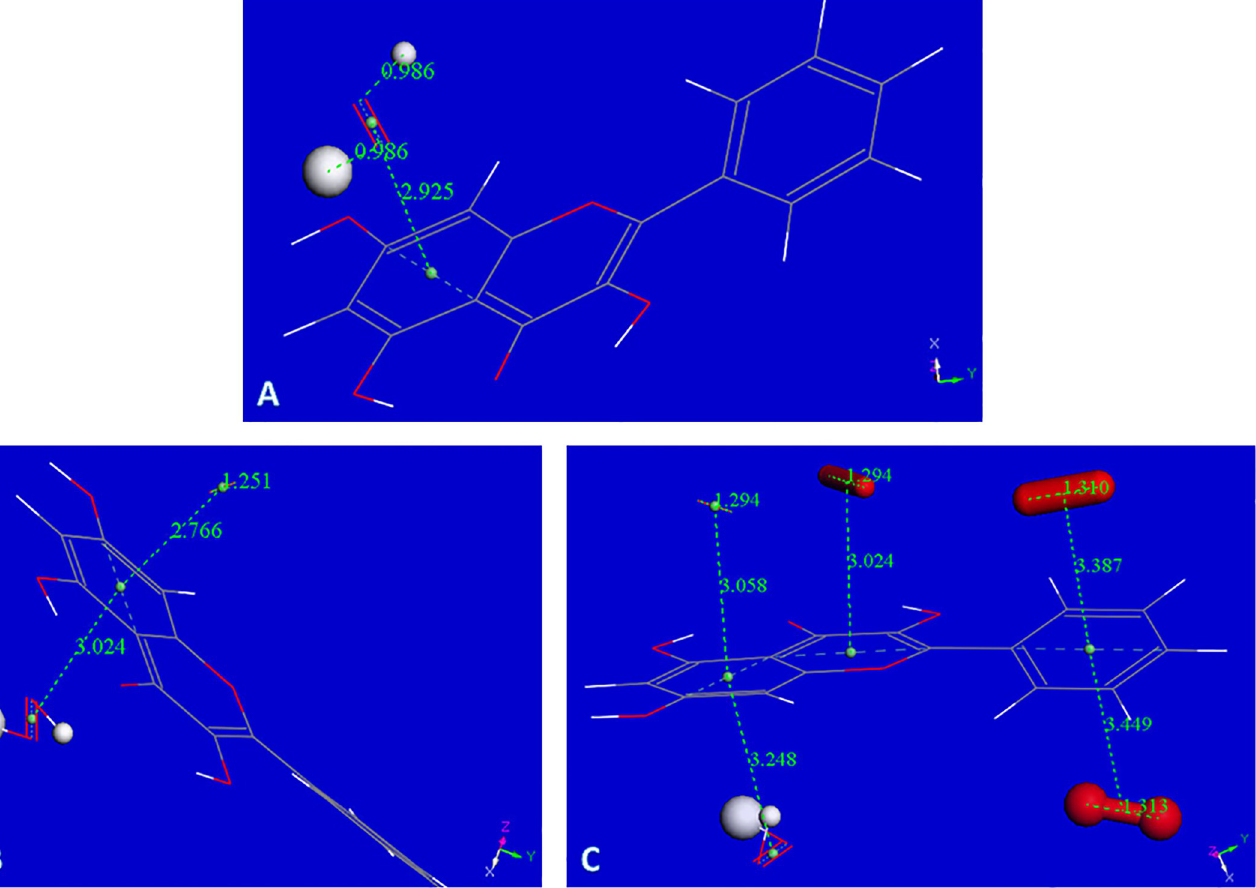
PLOS ONE | https://doi.org/10.1371/journal.pone.0267624 May 18,